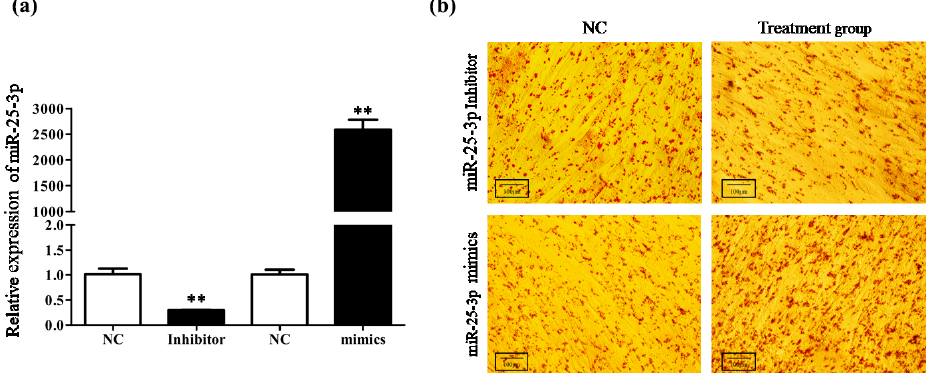
Figure 3. Knockdown miR-25-3p decreased the formation of lipid droplets in goat preadipocyte differentiation. (a) The transfection ef- ficiency of miR-25-3p mimics and miR-25-3p inhibitor was detected by qRT-PCR, compared with the negative control. (b) After 48h of preadipocyte differentiation, cells were fixed and stained with Oil Red O.